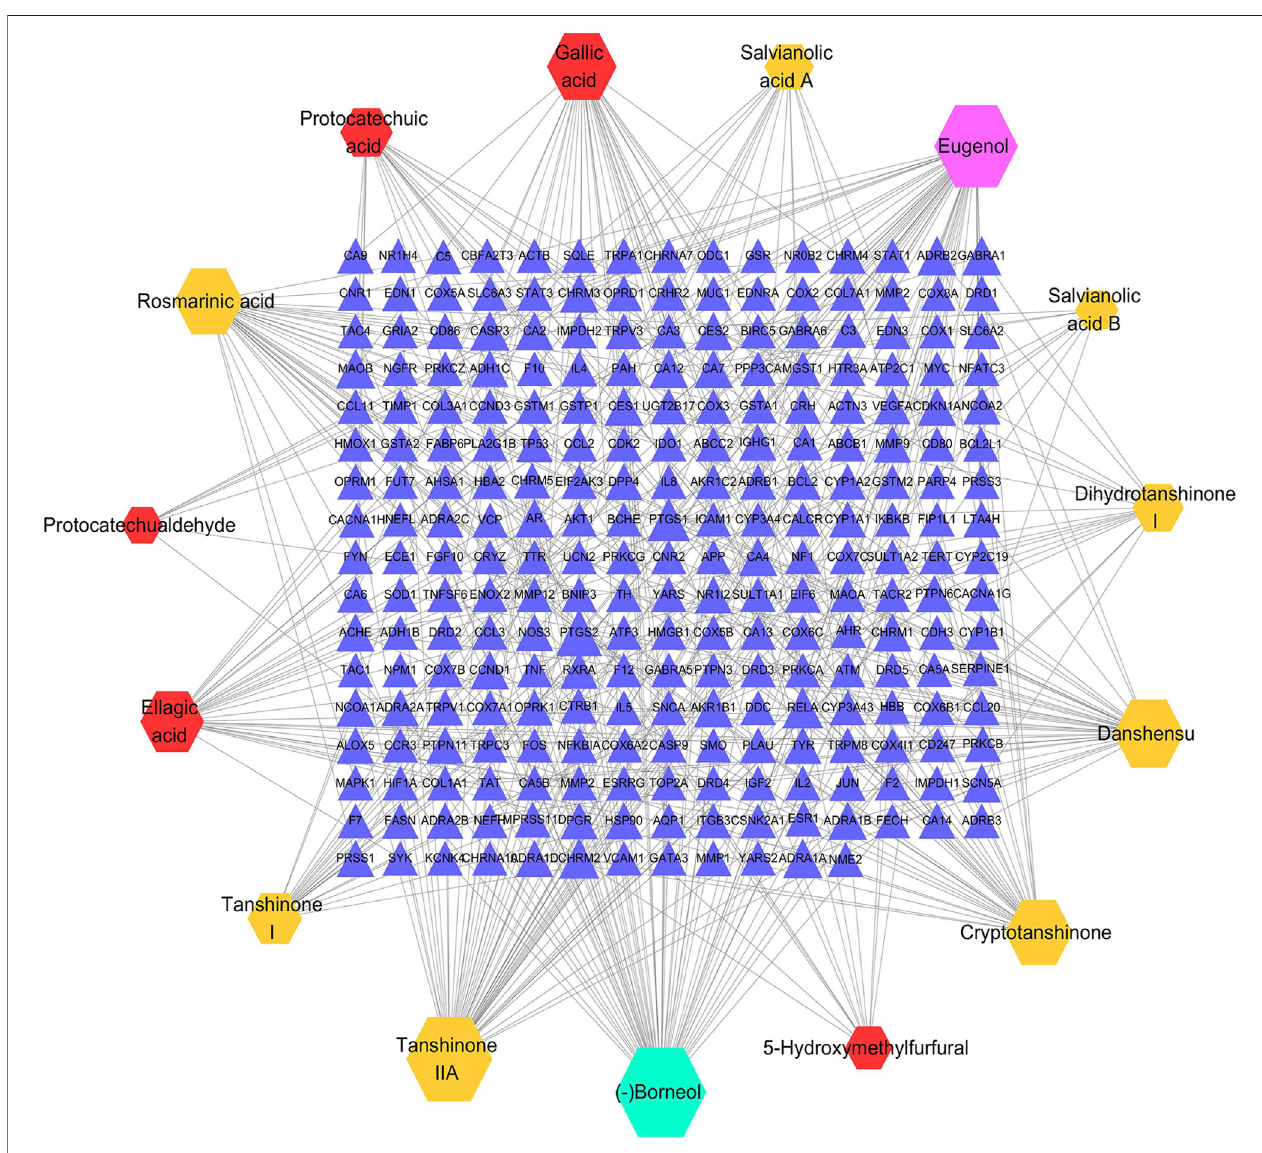
FIGURE 3 | The C-T network of GXSTC, the hexagons represent the components of Choerospondiatis fructus (red), Radix Salviae miltiorrhizae (orange), Salviae miltiorrhizae (purple) and Bomeolum (blue); the blue triangles represent the targets of GXSTC components.